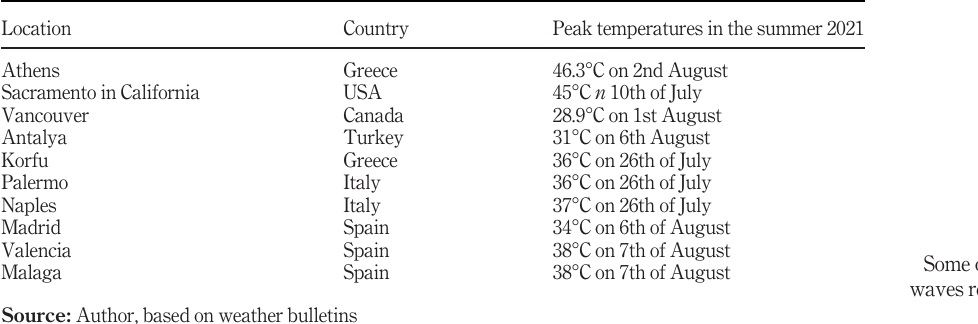
Figure 2. Some of the European sites affected